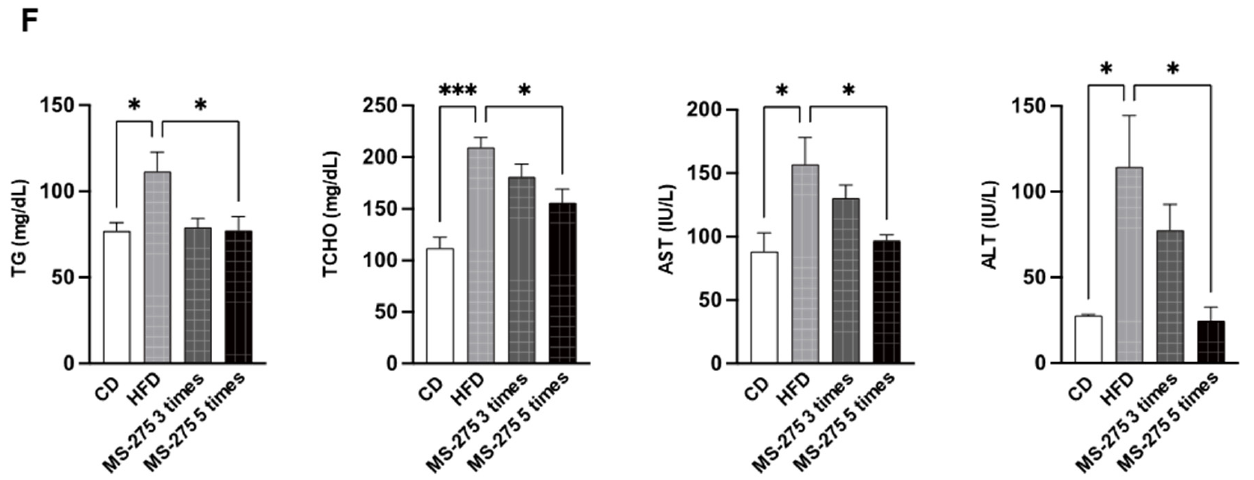
Figure 2. MS-275 ameliorated HFD-induced fatty liver in C57BL/6J mice. C57BL/6J mice were fed a CD or HFD for 14 weeks and intraperitoneally injected with dimethyl sulfoxide (DMSO) or MS-275 (10 mg/kg), five times every other day ( n = 5). ( A ) Schematic procedure of animal experiments; ( B ) Liver weight and ( C ) Hepatic TG content were analyzed at the end of the experiment. Hepatic lipids were detected by ( D ) H&E and ( E ) oil red O staining; Scale bar = 100 µ m. ( F ) Plasma levels of triacylglycerol (TG), total cholesterol (TCHO), aspartate aminotransferase (AST), and alanine aminotransferase (ALT) were measured using an auto-chemical analyzer. * p < 0.05, ** p < 0.01, *** p < 0.001 vs. HFD (one-way ANOVA).